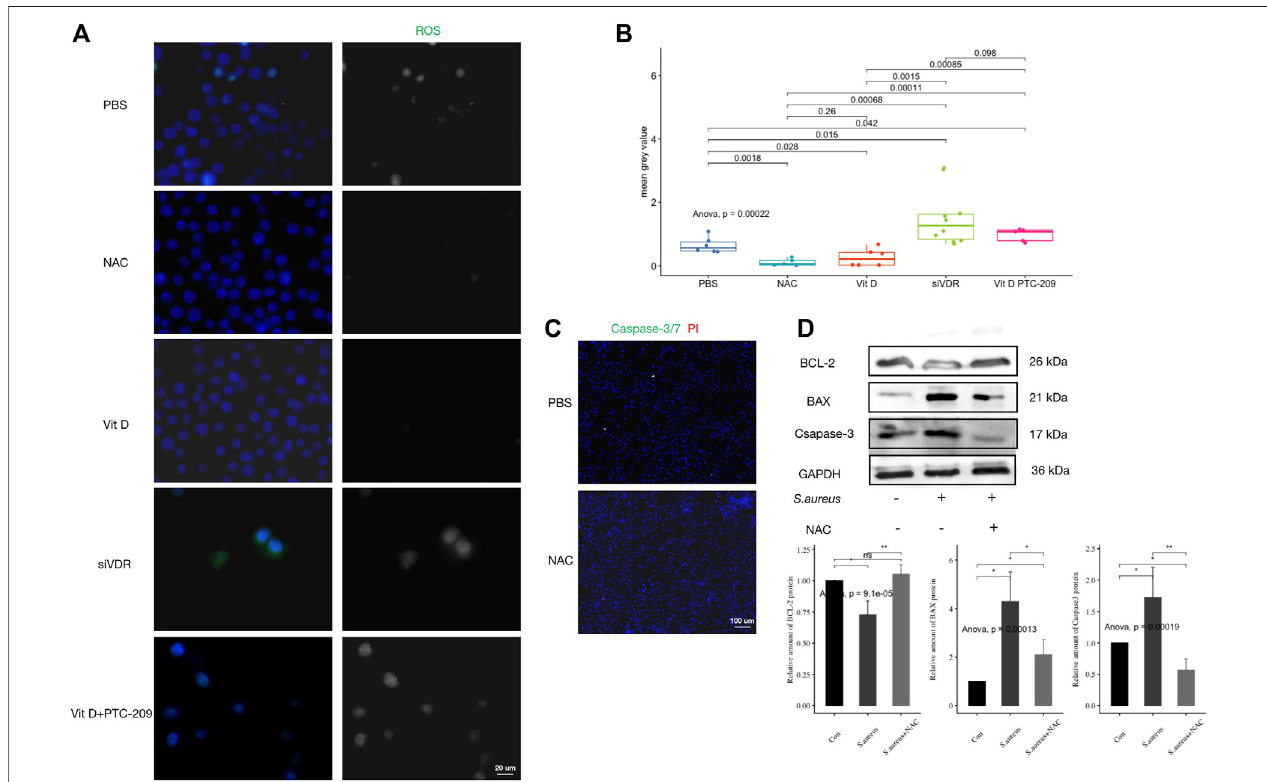
FIGURE 5 | Vitamin D inhibited excessive ROS expression during S. aureus associated infection. (A) ROS generation fl uorescence detection, ROS (green). Magni fi cation, 1,000×. (B) Mean grey value of ROS generation. (C) Apoptosis detection, caspase-3/7 (green) and PI (red). Magni fi cation, ×200. (D) Result of western blotting for apoptosis-related proteins. “ ns ” for not signi fi cant, * p < 0.05, ** p < 0.01, and *** p < 0.001.